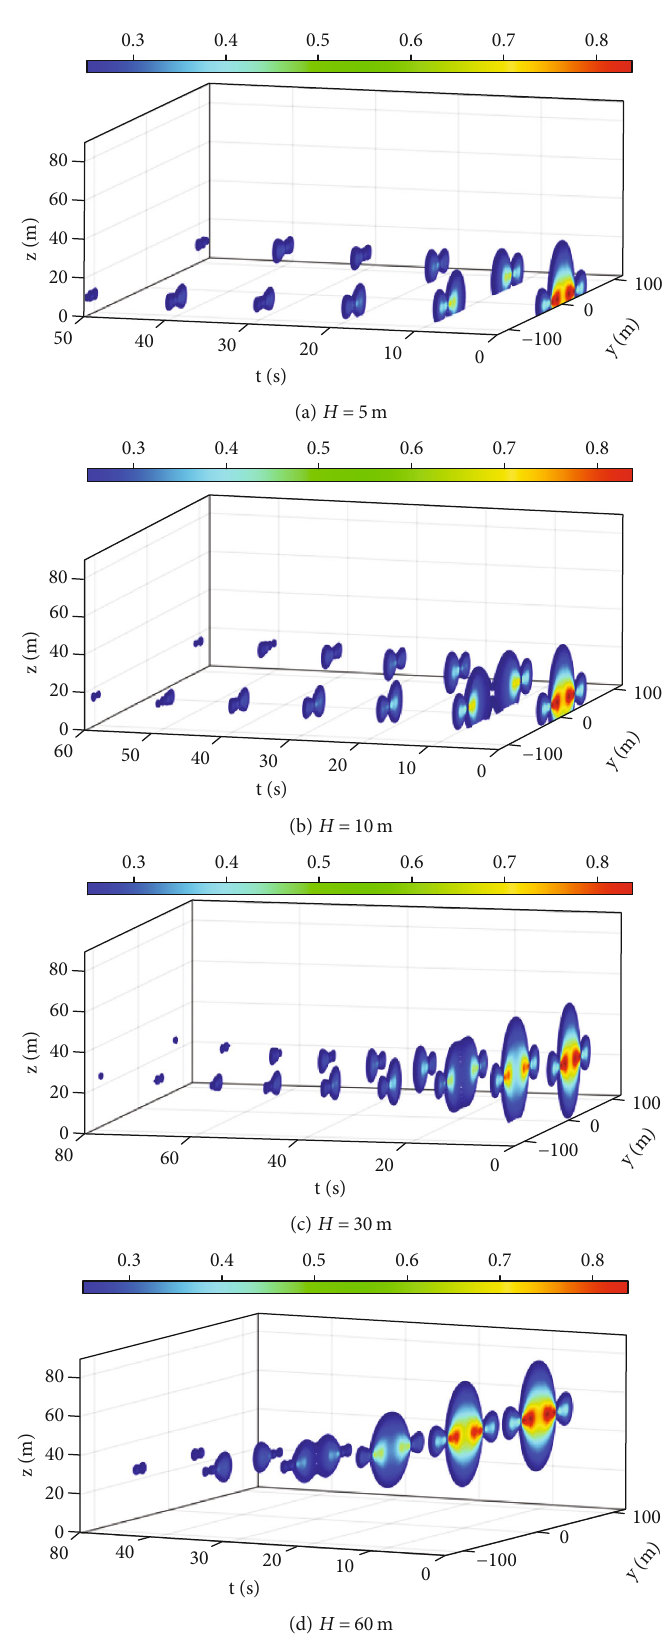
Figure 22: Variation in the roll hazard zone with time at di ff erent